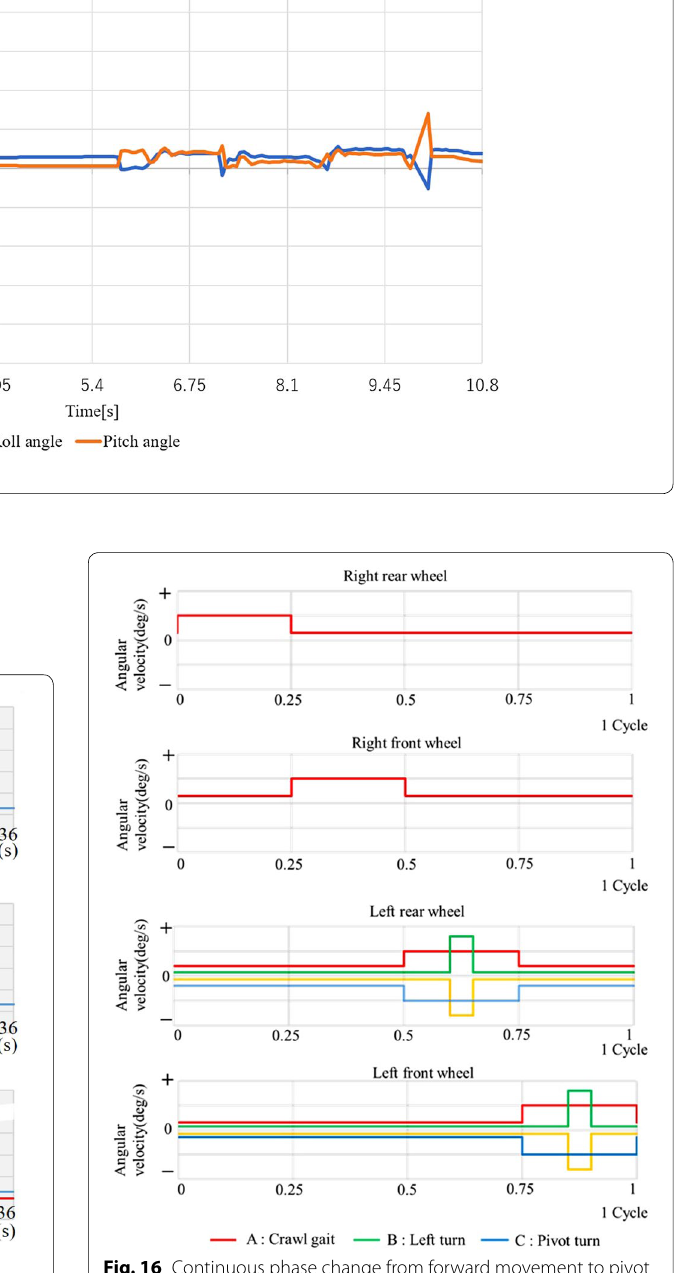
Fig. 16 Continuous phase change from forward movement to pivot